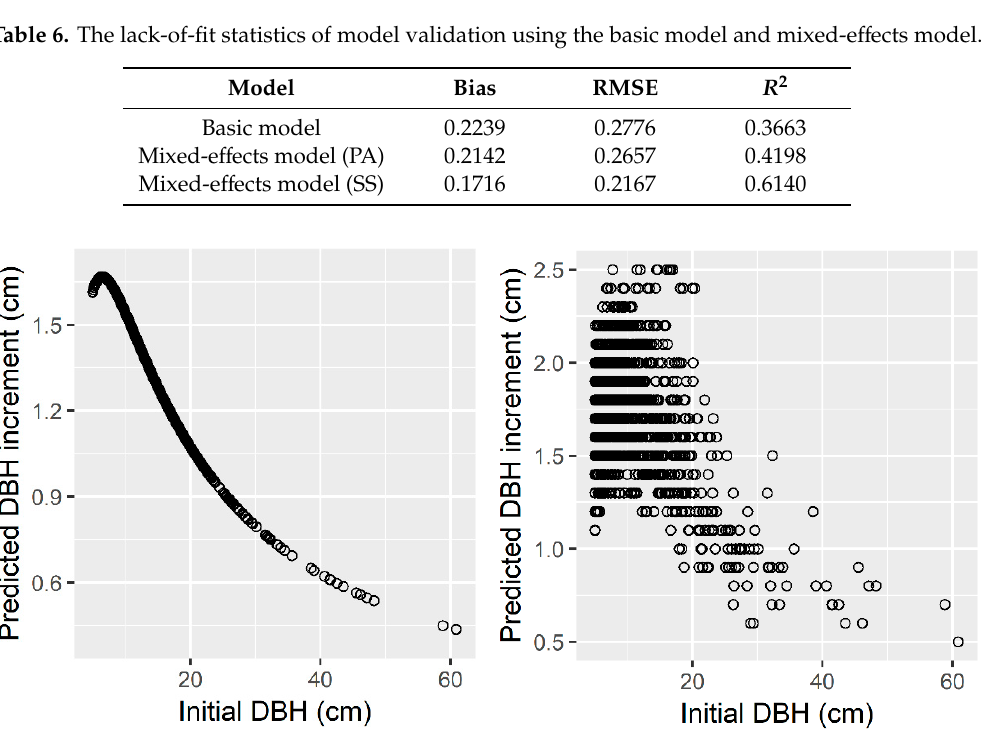
Figure 4. Predicted DBH increments derived from the basic model (Equation (24)) and mixed-effects model (Equation (26)) over DBH with all other predictors set to their mean for oaks in Hunan Province, south-central China.